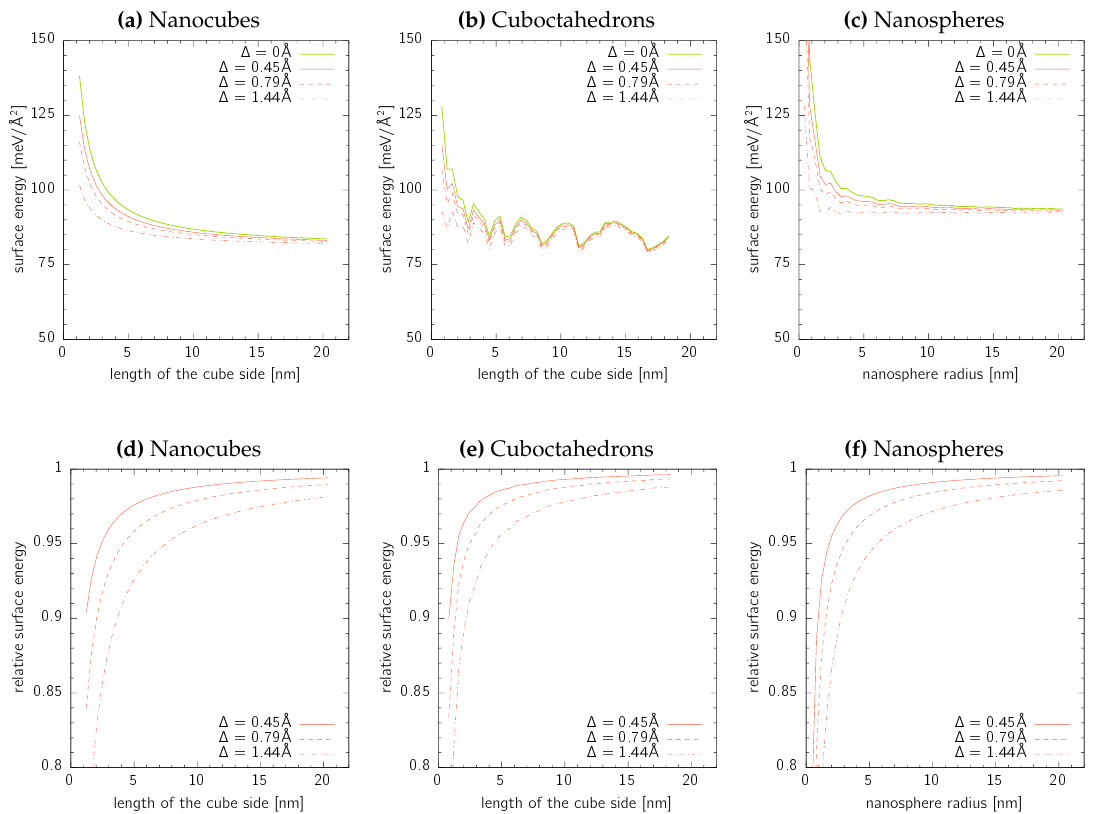
Figure 5. Corrected absolute (upper row) and relative values (lower row) of the surface energies for ( a , d ) nanocubes, ( b , e ) cuboctahedrons, and ( c , f ) nanosheres. The relative surface energies are calculated with respect to the values without correction for the electronic cloud thickness ( ∆ = 0).